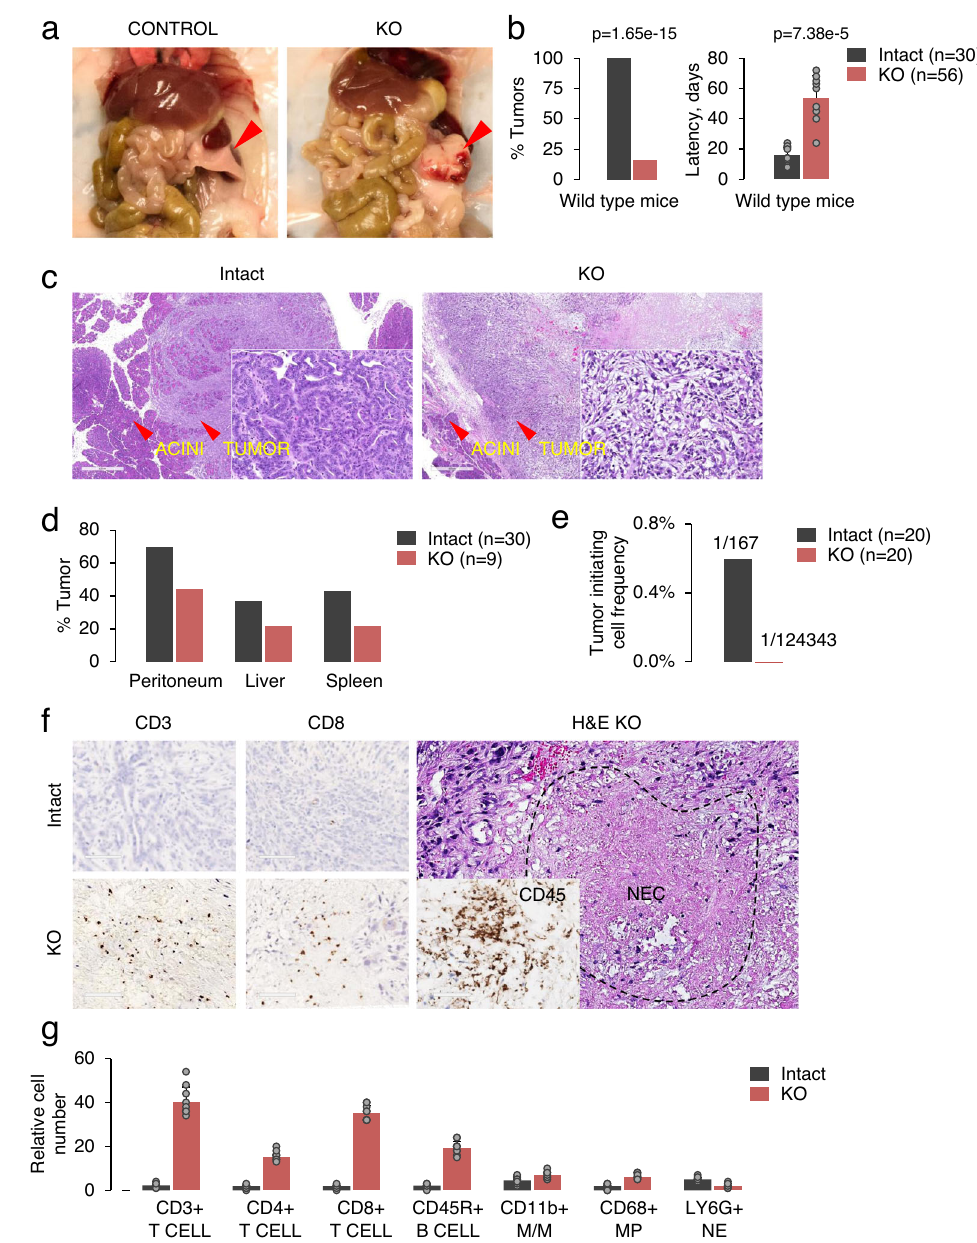
Fig. 2 KRAS KO tumors fail to evade host immune system. a Orthotopic pancreatic tumor in wild-type C57BL/6 mice derived from KRAS KO KPC cells. Normal pancreas is shown on left (control). b Bar graphs showing the quanti fi cation of wild-type mice with tumors formed by KRAS intact and KRAS KO KPC cells and the respective tumor latencies ( n = 86 individual mice). Data are expressed as mean ± SD. Signi fi cance was determined using Fisher ’ s exact test (left panels) or two-tailed t -test at the 0.05 con fi dence interval (right panels). c Histological appearance of orthotopic tumors arising from KRAS intact and KRAS KO KPC cells. Scale bar 600 μ M. d Bar graphs display the quanti fi cation of mice with metastatic foci. e Quanti fi cation of tumor-initiating cells (TIC) in KRAS intact and KRAS KO KPC cells in wild-type mice. f IHC staining of tumors shown in ( c ) with antibodies noted. Areas of necrosis (NEC) are present in KRAS KO but not KRAS intact KPC tumors. Scale bar 100 μ M. g Bar graph showing the quanti fi cation of tumor-in fi ltrating immune cells in KRAS intact and KRAS KO KPC tumors ( n = 3 independent experiments). Relative cell number per 10 high power fi elds is shown. Individual points represent separate high power fi elds. Data are presented as mean ± SD, two-tailed t